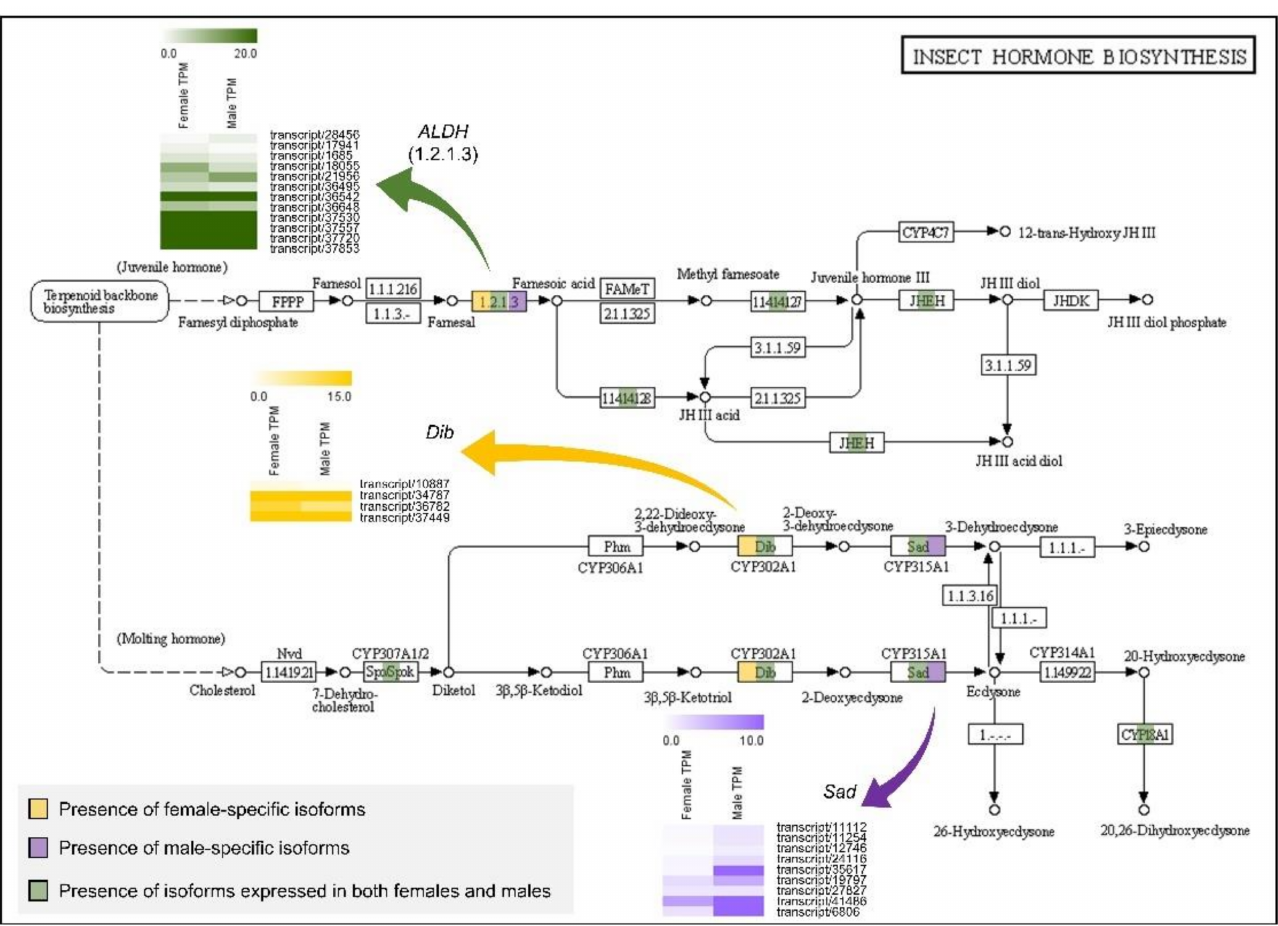
Figure 5. Expression differences in female and male Artemia franciscana transcriptome for the insect hormone biosynthesis KEGG pathway. Colored boxes in the Kyoto Encyclopedia of Genes and Genomes (KEGG) pathway indicate the presence of female-specific isoforms (yellow), male-specific isoforms (purple), and isoforms expressed in both sexes (green). Heatmaps represent the expression patterns of ALDH (1.2.1.3, green), Dib (yellow), and Sad (purple) genes. The color scales indicate relative expression levels by transcripts per million (TPM) values. ALDH, aldehyde dehydrogenase; Dib, disembodied; Sad,